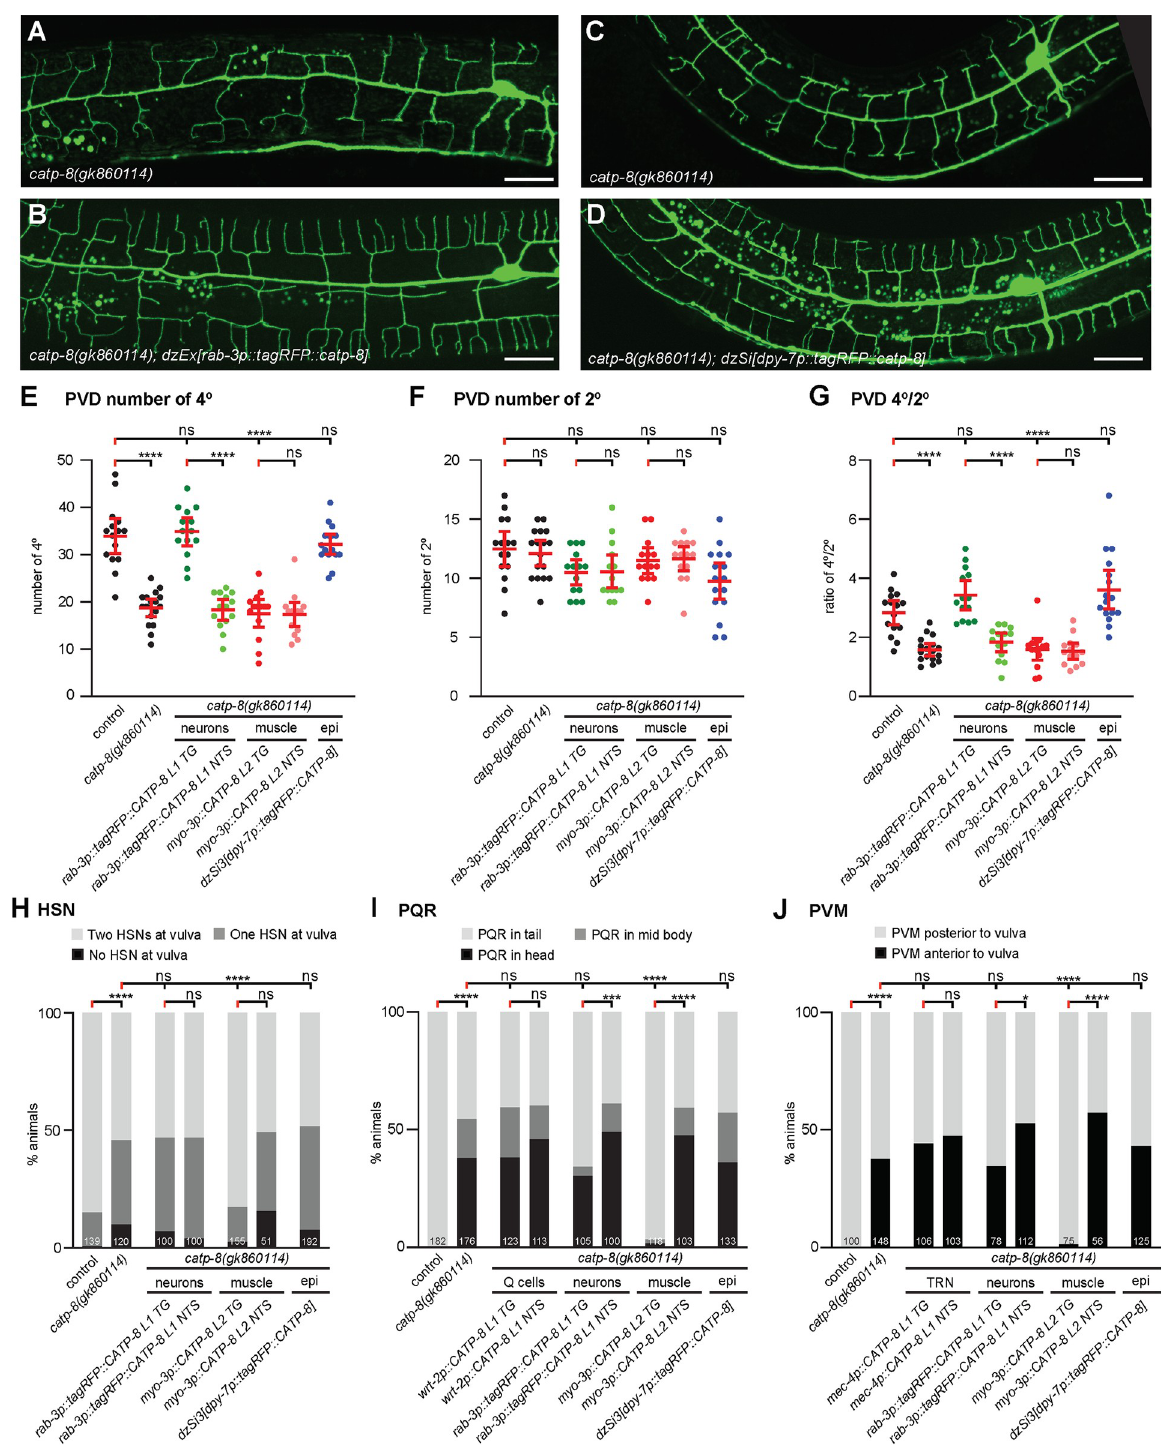
Fig 5. CATP-8/P5A-ATPase can function cell autonomously and non-autonomously during neural patterning. A.—B. Maximum z- projection of confocal images of the PVD::GFP marker wdIs52 from non-transgenic (A) and transgenic (B) sibling animals carrying the pan- neuronal catp-8 rescueing array in a catp-8(gk860114) mutant background, showing restoration of PVD structure upon neuronal expression. Scale bar = 20 μ m. C.—D. Maximum z-projection of confocal images of the PVD::GFP marker wdIs52 from animals without (C) and with (D) single-copy insertion of epidermal catp-8 rescue under catp-8 mutant background, showing restoration of PVD structure under epidermal rescue. Scale bar = 20 μ m. E.—G. Quantification of number of quaternary branches (E), secondary branches (F), and the ratio of quaternary to